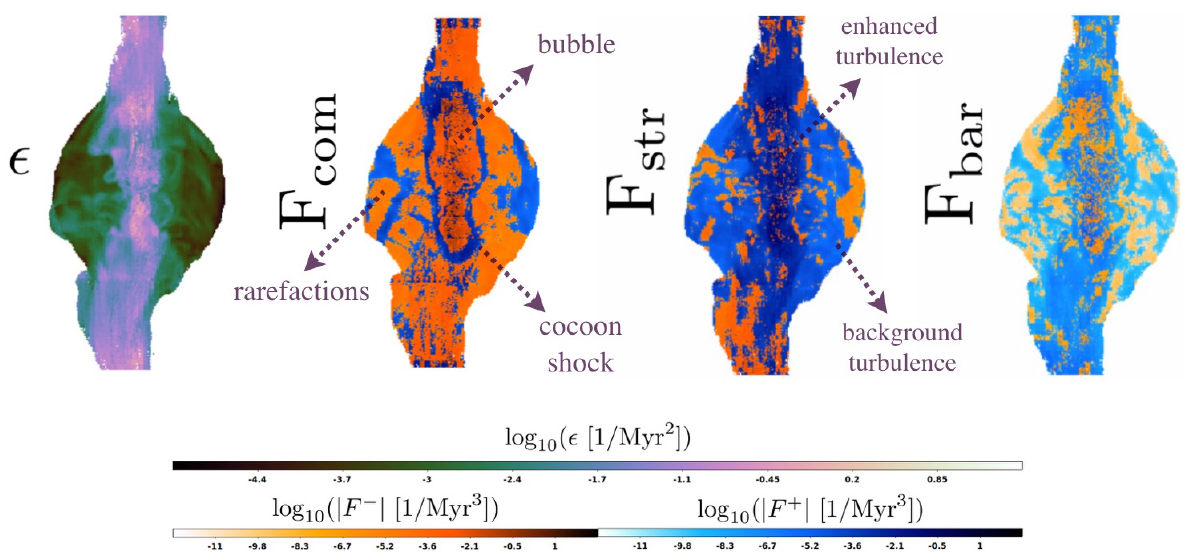
Figure 13. The macro AGN feedback transfer and deposition highlighted via the enstrophy (cid:101) decomposition (Equation (17)) into its main positive/negative components: compressions/rarefactions (second panel), stretching/squeezing motions (third), baroclinicity (fourth)—adapted from Wittor and Gaspari [239]. This is achieved via Lagrangian tracer particles on top of an adaptive-mesh-refinement HD simulation of self-regulated AGN outflows/jets in a central massive galaxy (Gaspari et al. [156]). The cycle of CCA rain, AGN outflow injection, bubble inflation, cocoon shock expansion, and turbulence cascade repeats self-similarly over several billion years, recurrently quenching the macro cooling